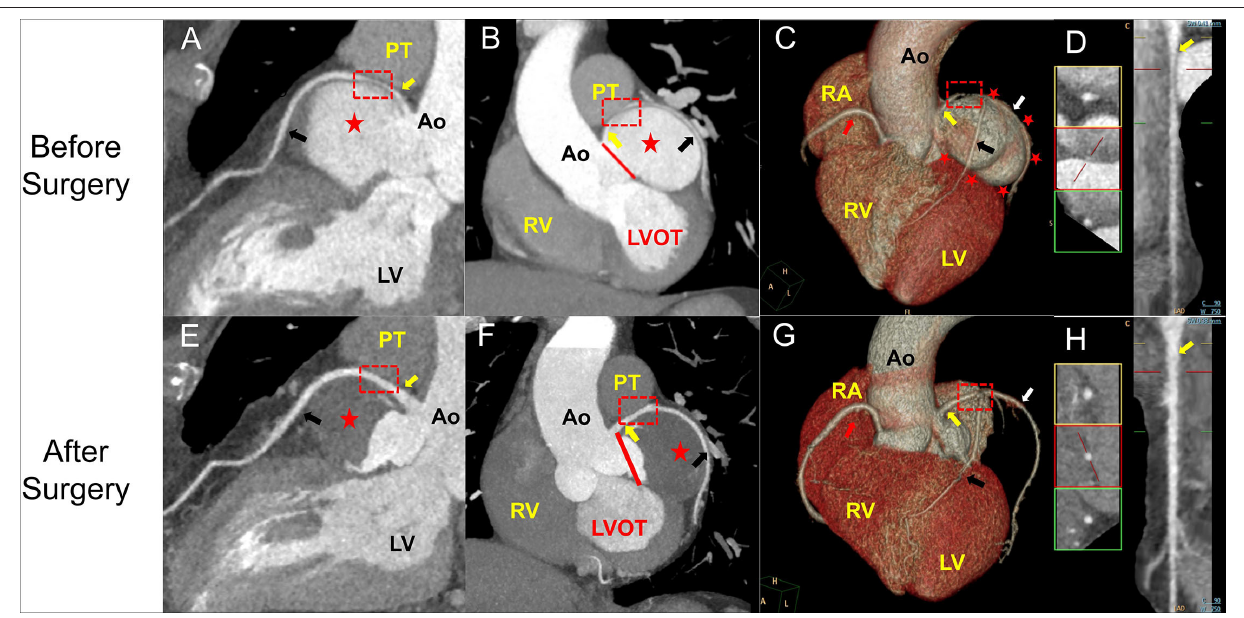
FIGURE 1 | Transthoracic echocardiogram (TTE) showed a giant aneurysm at the parasternal aortic short axis view that was originated from the left sinus of Valsalva (A) . Communication of the blood flow was detected between the aneurysm and the aorta (B) . TTE, transthoracic echocardiogram; RVOT, right ventricle outflow tract; Ao, aorta; LA, left atrium; red star, sinus of Valsalva aneurysm (SoVA).